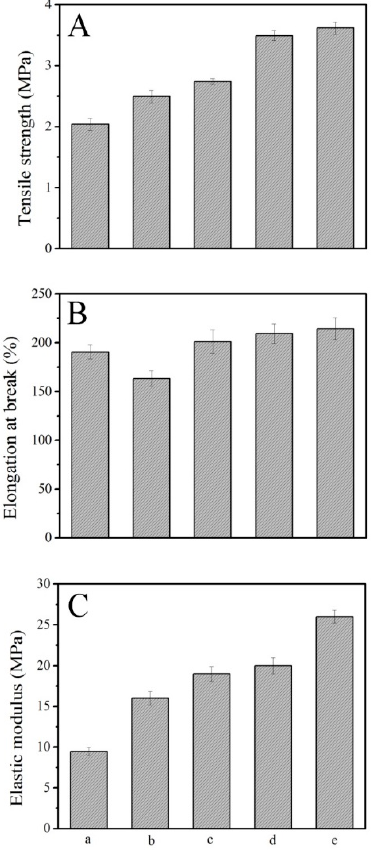
Figure 9. Tensile strength ( A ); elongation at break ( B ); and elastic modulus ( C ); LCPU ( a ); LCPU5 ( b ); LCPU10 ( c ); LCPU15 ( d ); LCPU20 ( e ).